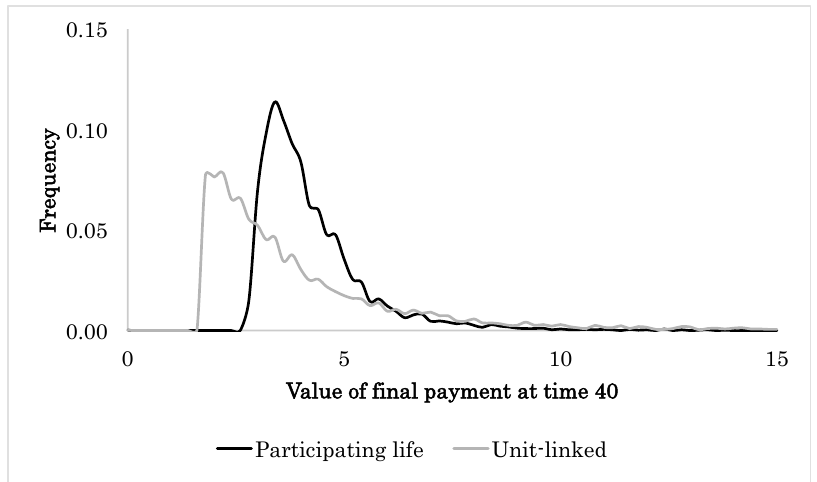
Figure 12. Empirical distribution of final payments for the participating life insurance policy and the unit-linked insurance